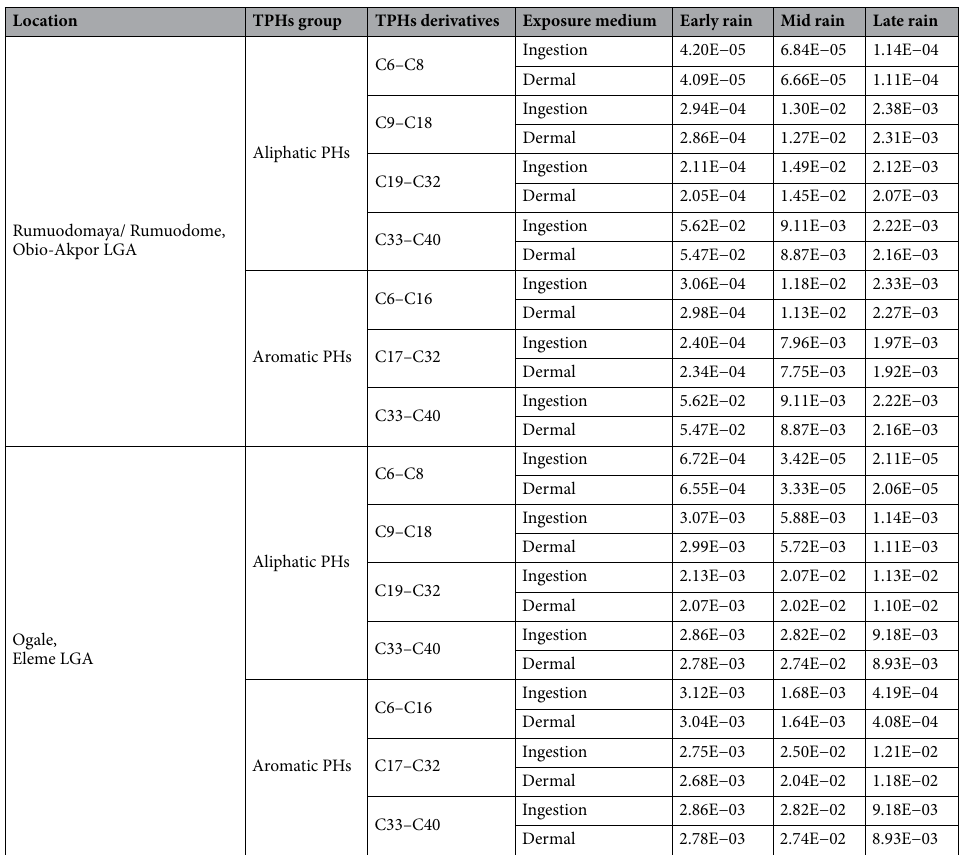
Table 9. Average daily intake of TPHs exposure in rainwater for